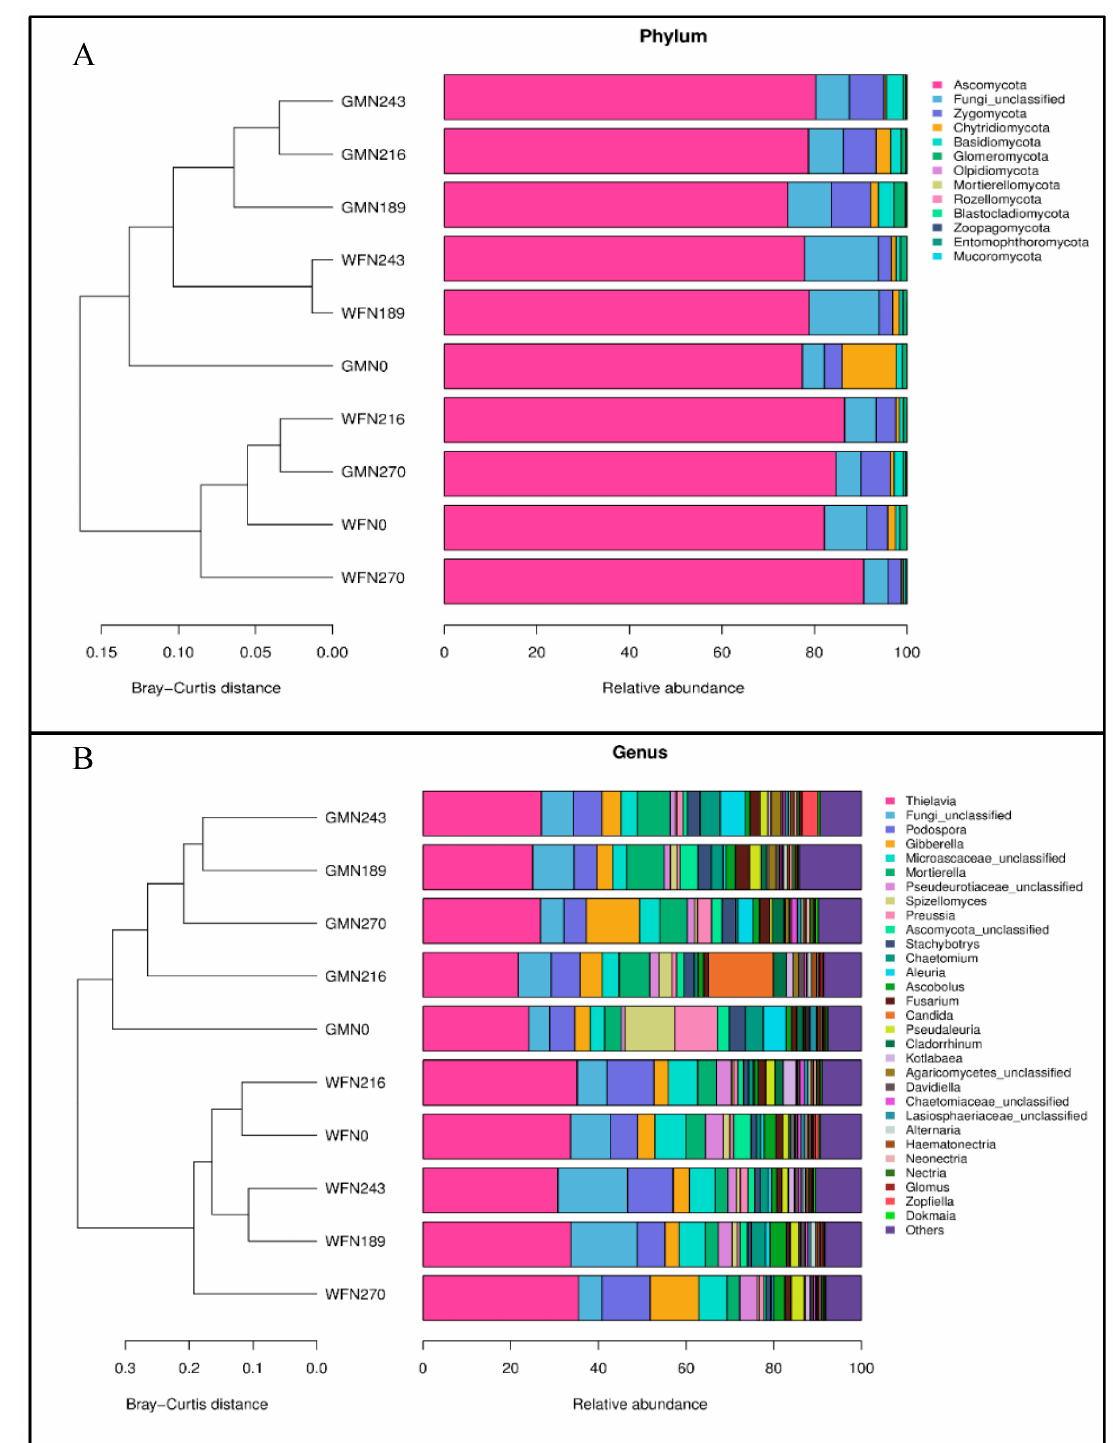
Figure 7. The soil fungal phylum and genus abundance group clusters response to N application under WF and GM treatments in the North China Plain. ( A ), Phylum level; ( B ), Genus level.